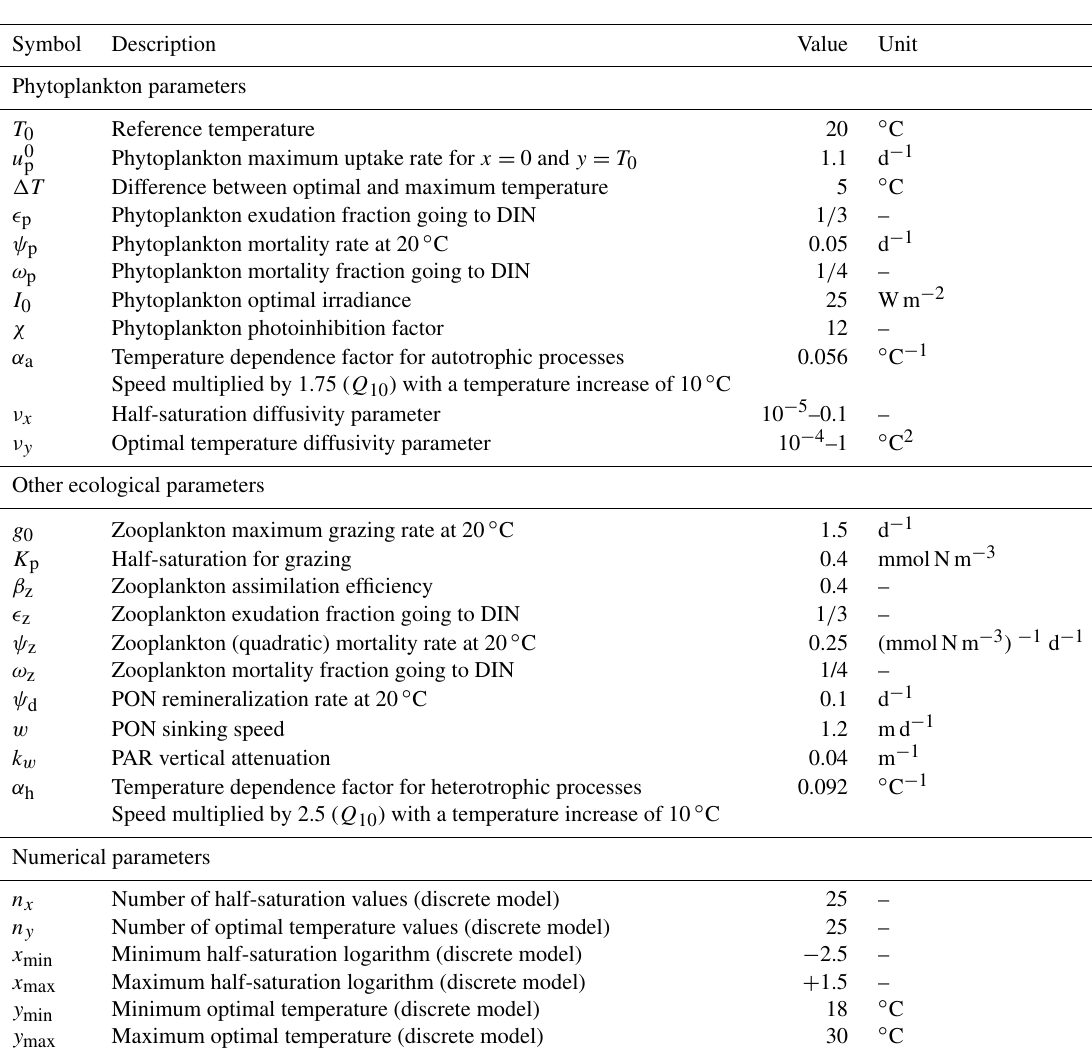
Table 2. Parameters of the ecosystem